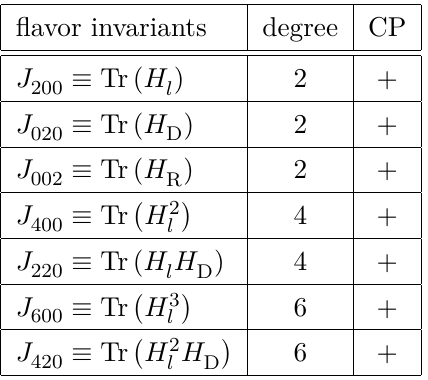
Table 1 . Summary of the basic flavor invariants in the generating set along with their degrees and CP parities in the case of one-generation RH neutrino, where q , M and M , M D R l